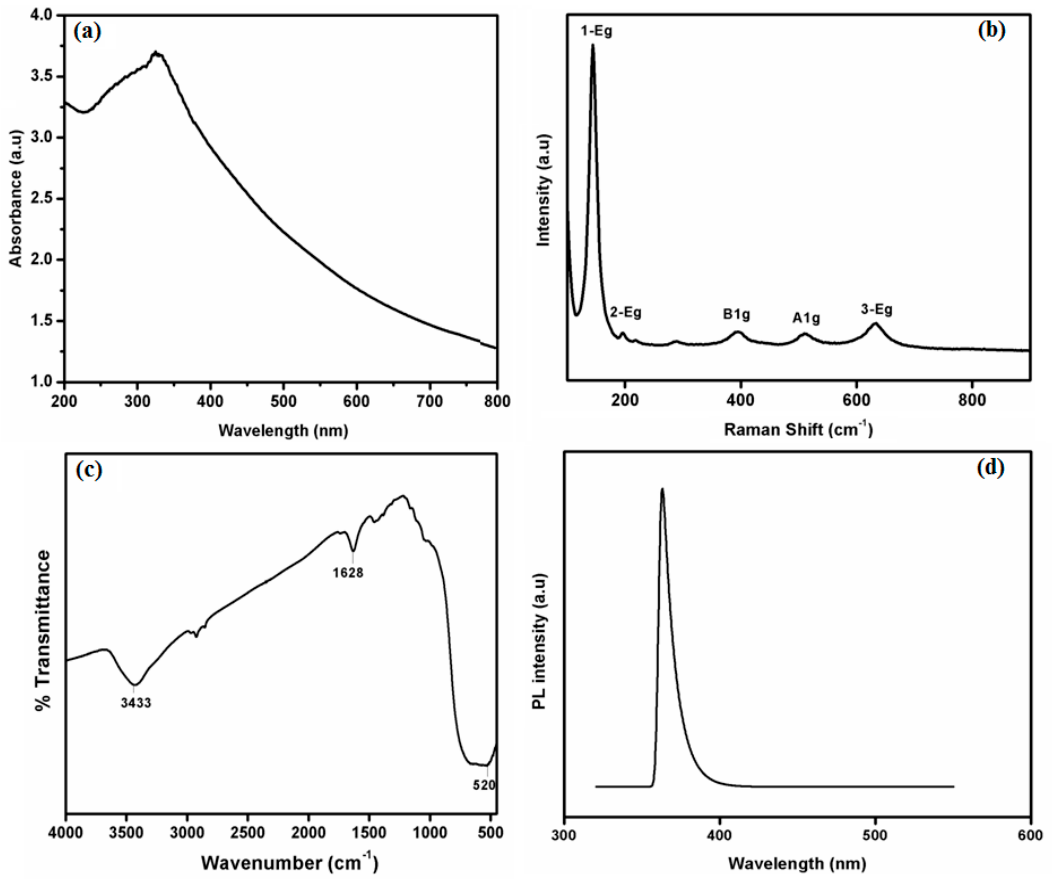
Figure 3. ( a ) UV–Vis absorption spectrum, ( b ) room temperature Raman spectrum, ( c ) FTIR and ( d ) PL spectrum of Fe-doped TiO 2 nanoparticles.